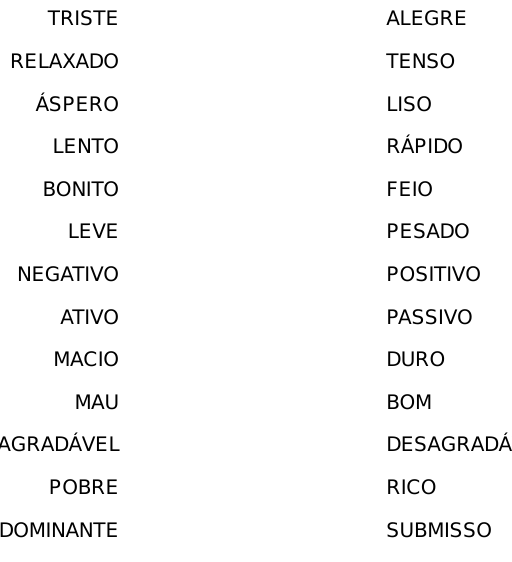
Figura 1 . Instrumento de diferencial semântico utilizado neste